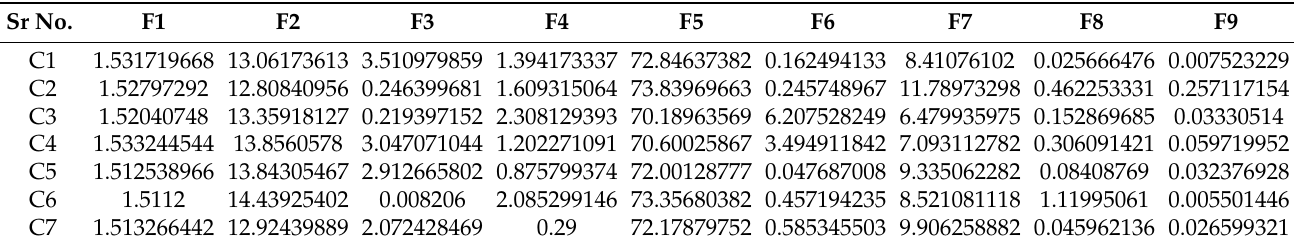
Table 18. The best centroids for Glass obtained by proposed approach.